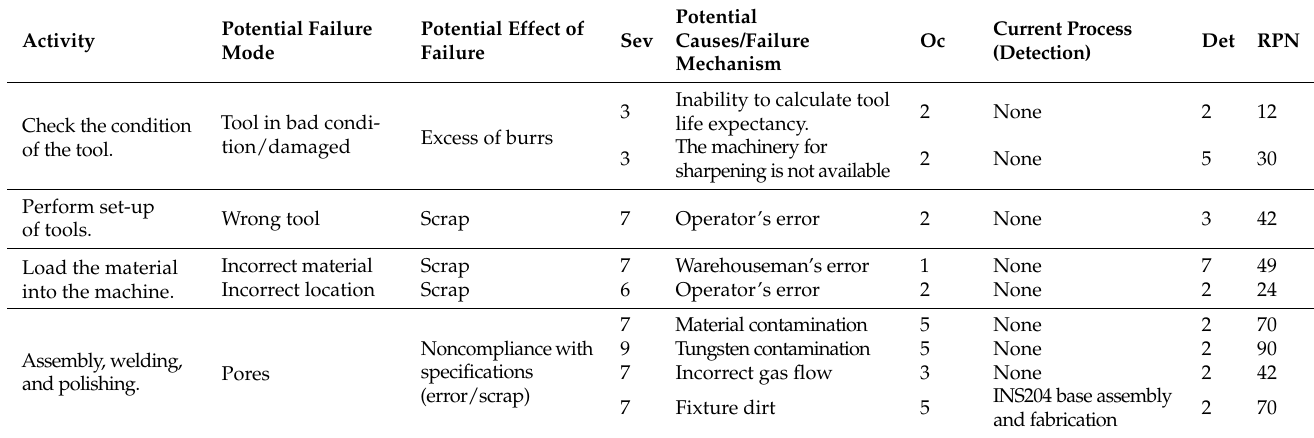
Table 13. FMEA analysis used to control and monitor activities.